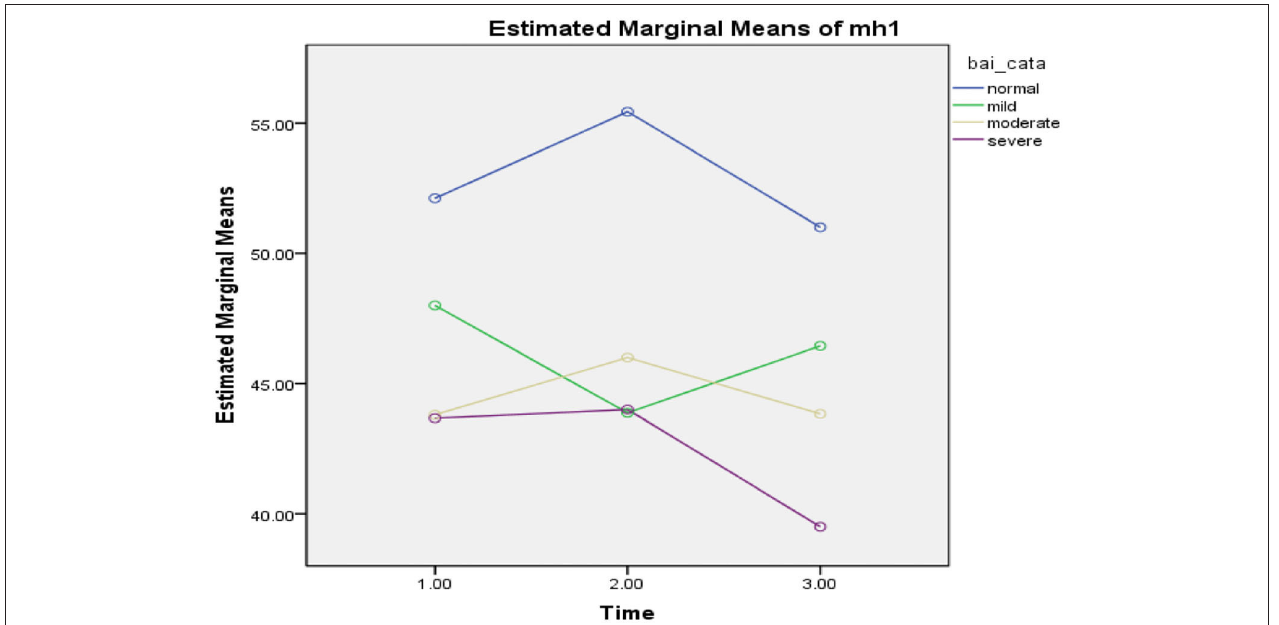
FIGURE 5 | Mean difference of mental health between T-0 (pretesting phase), T-1 (posttesting phase), and T-2 (follow-up phase) with different levels of anxiety in Pakistan students during the COVID-19 epidemic lockdown ( N = 40). Time, three phases; bai_cata, severity level of anxiety; quality of life total, quality of life.